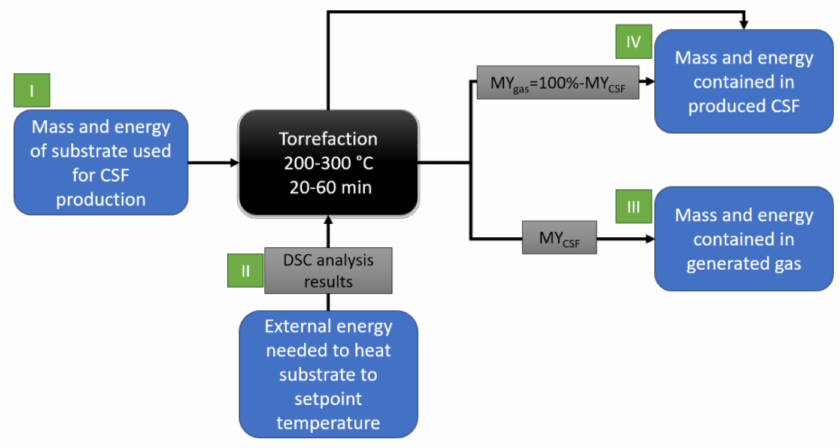
Figure 1. Theoretical mass and energy balance of the torrefaction process, calculations